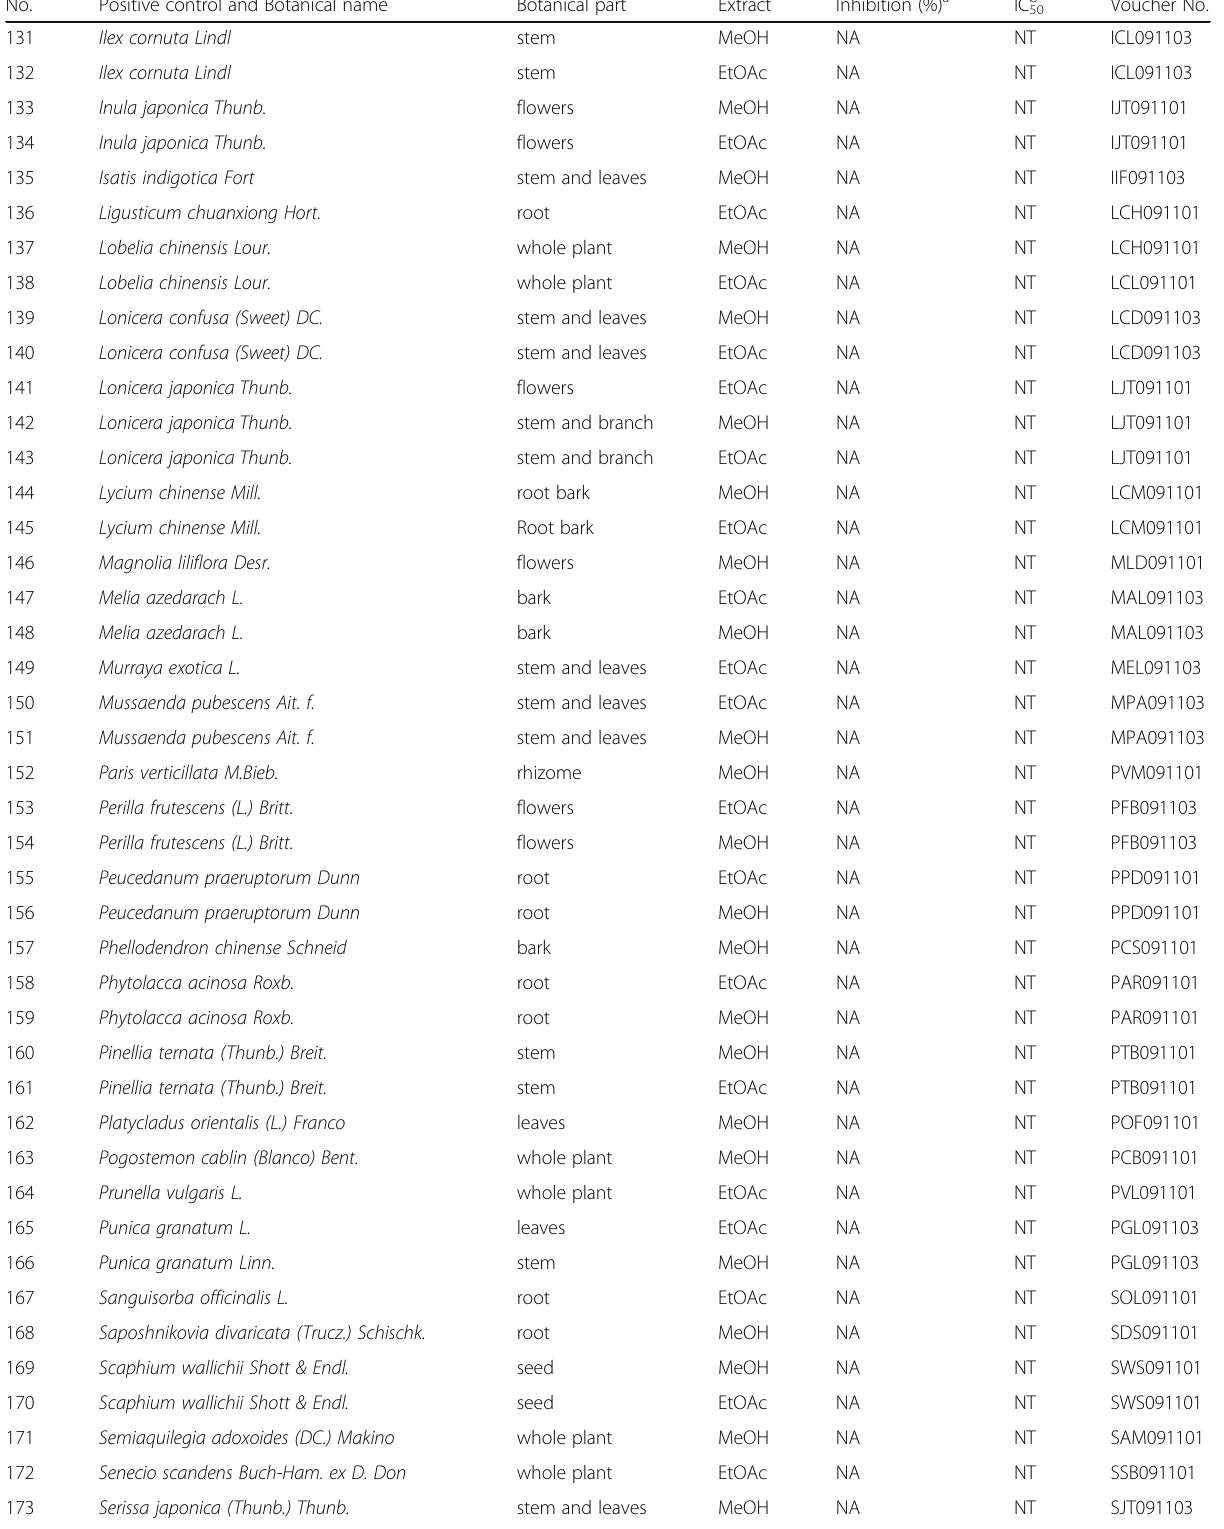
Table 1 Inhibitory activities of Chinese herbs extract on A(H1N1) influenza virus neuraminidase (Continued) No. Positive control and Botanical